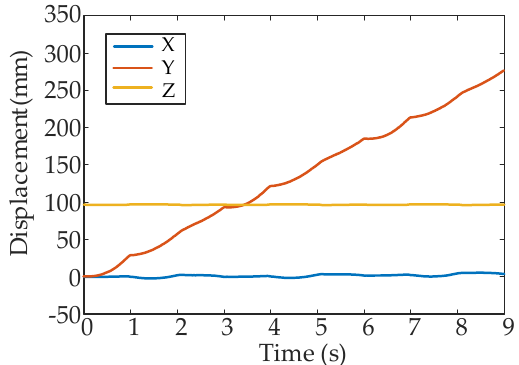
Figure 21. The displacement of hexapod body with leg 2 fault.